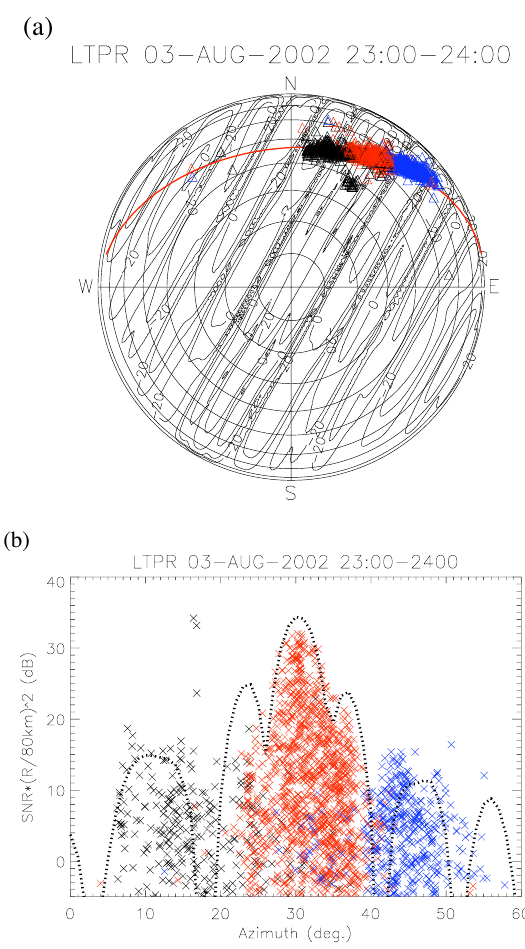
Fig. 6. (a) Distributions of arrival angles for FAI echoes from 2300 to 2400 JST 3 August 2002. Thick red line indicates di- rections in which line of sight is perpendicular to geomagnetic field line at 100km altitude. Colors indicate the ranges of echoes. (Black: Range ≤ 155km, Red: 155 < Range ≤ 185km, Blue: Range > 185km). Beam pattern of the LTPR (two-way) has also been plot- ted. (b) Distribution of echo power measured by the receiving array over azimuth angle for the echoes plotted in (a). Range correction with respect to the reference range of 80km has been done. Colors indicate the ranges of echoes in the same way as in (a). Dashed line shows the shape of the “two-way” antenna pattern in logarithmic scale along the locus of perpendicularity at 100km